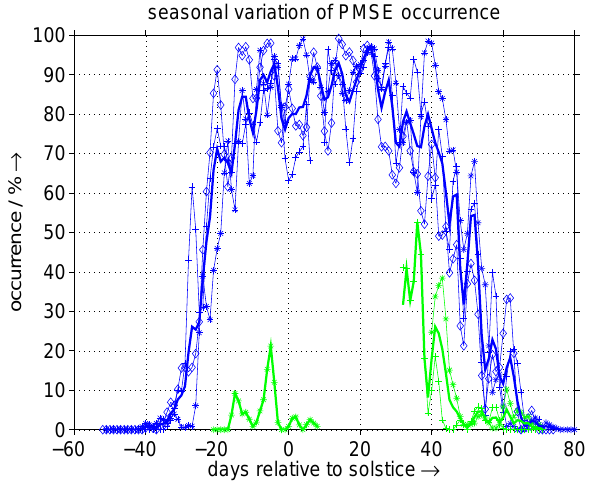
Fig. 14. Seasonal variation of PMSE occurrence above Andenes (2004–2006, blue) and Resolute (2004–2005, green) based on radar volume reflectivities ≥ 1 × 10 − 15 m − 1 . The thin lines with symbols represent the individual years: + 2004, ? 2005, and (cid:5)